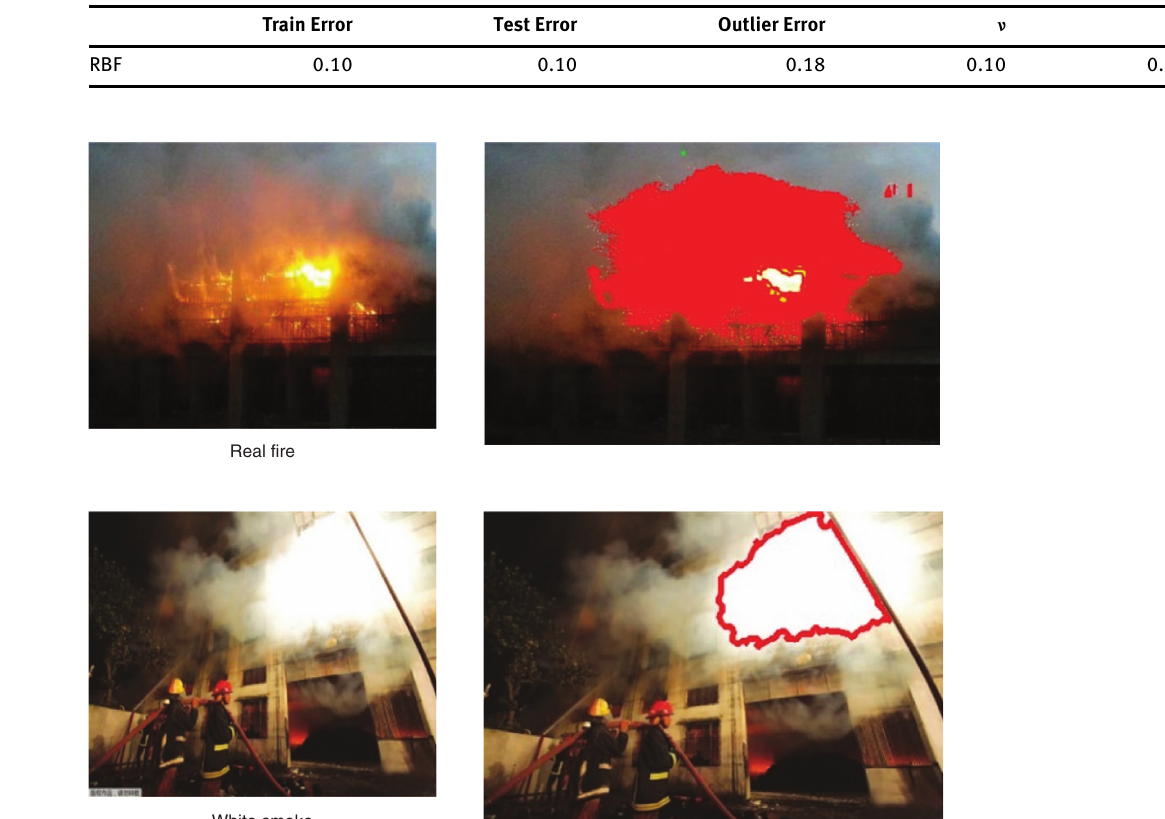
Table 1: Parameters and Evaluation Results of Trained SVM Models.